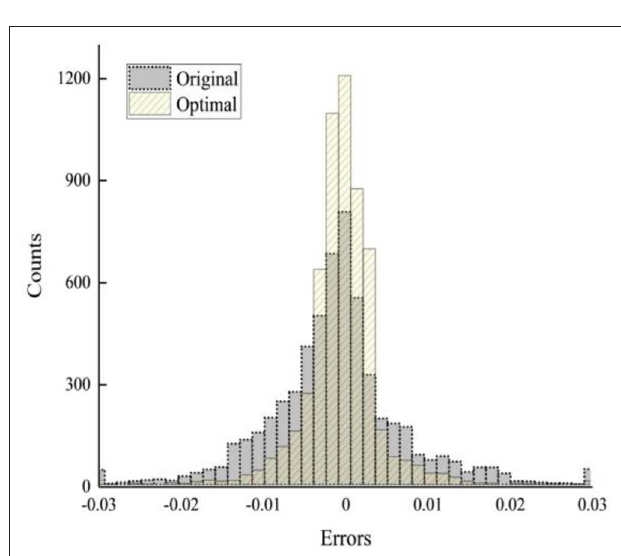
MR damper are matched well with the predicted